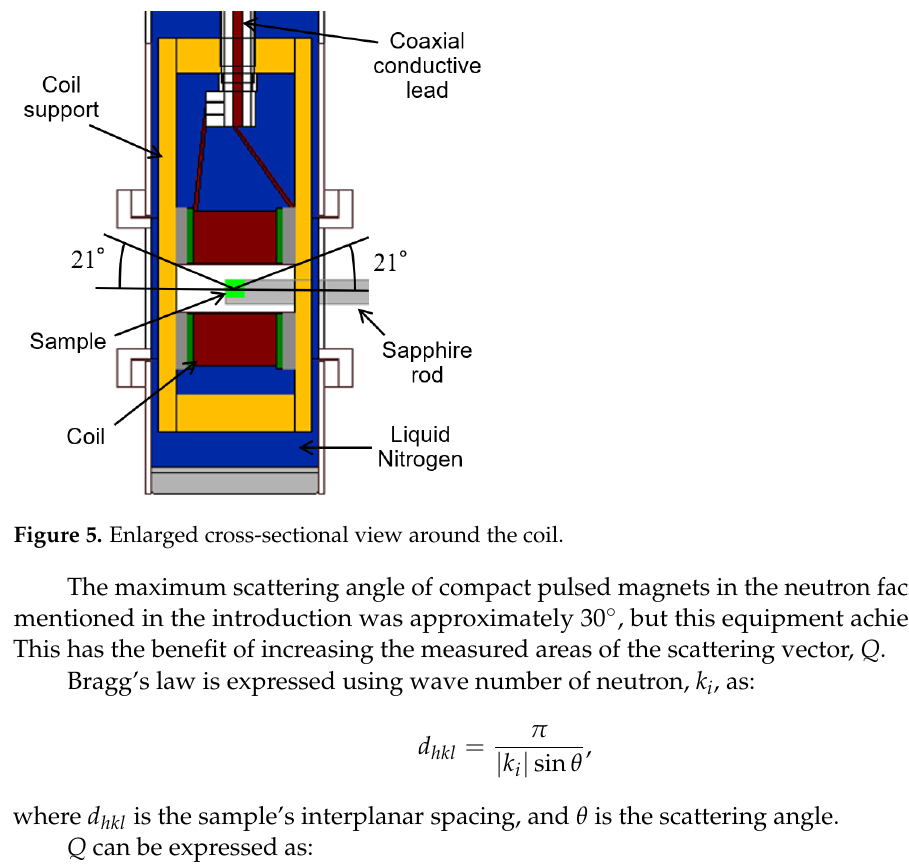
Figure 4. Cross-sectional view of the new pulsed magnet system.